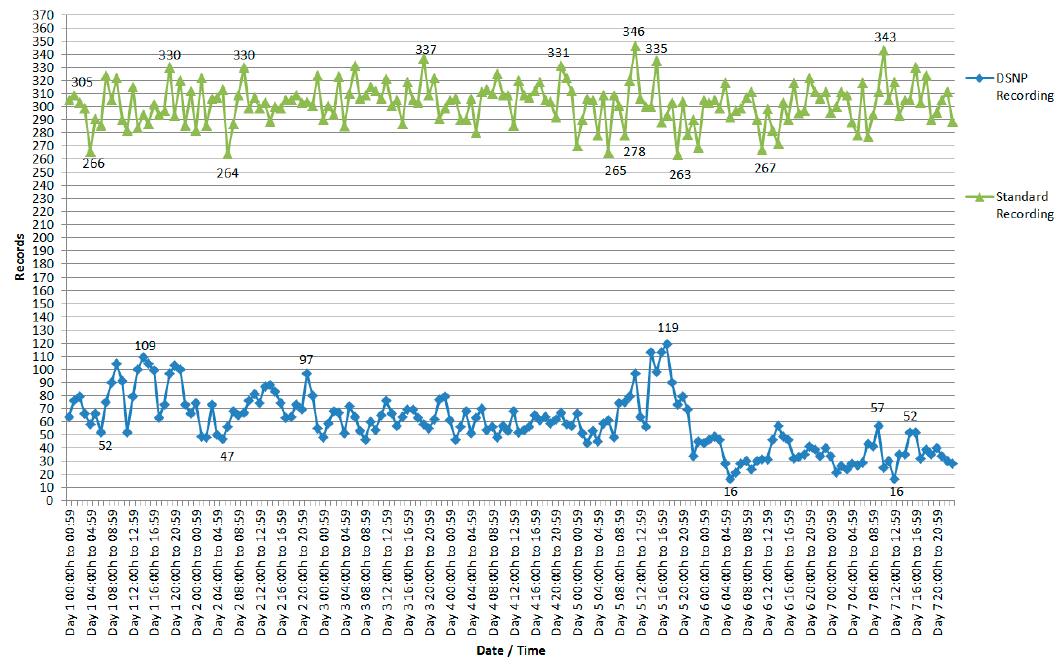
Figure 6. Number of records sent per each temperature sensor.